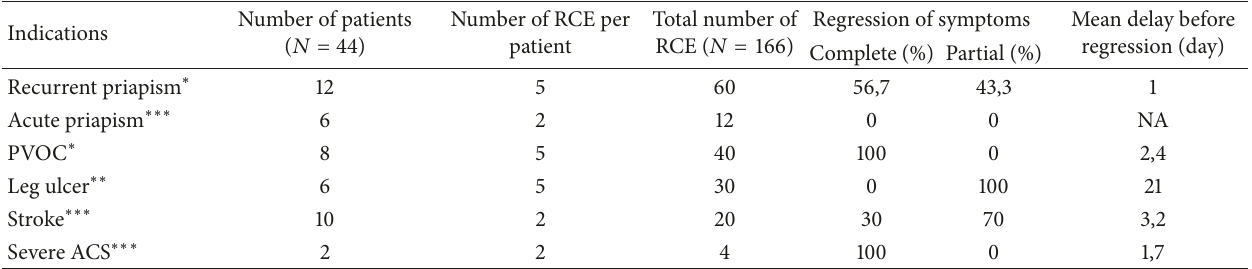
Table 1: Indications and clinical evolution of patients after RCE. Indications